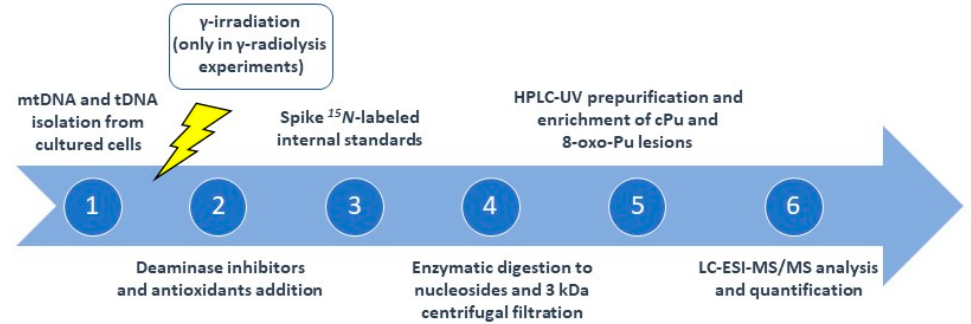
Figure 3. Flow diagram showing protocol steps for the quantification of cPu and 8–oxo–Pu lesions via isotope–dilution LC–ESI–MS/MS.